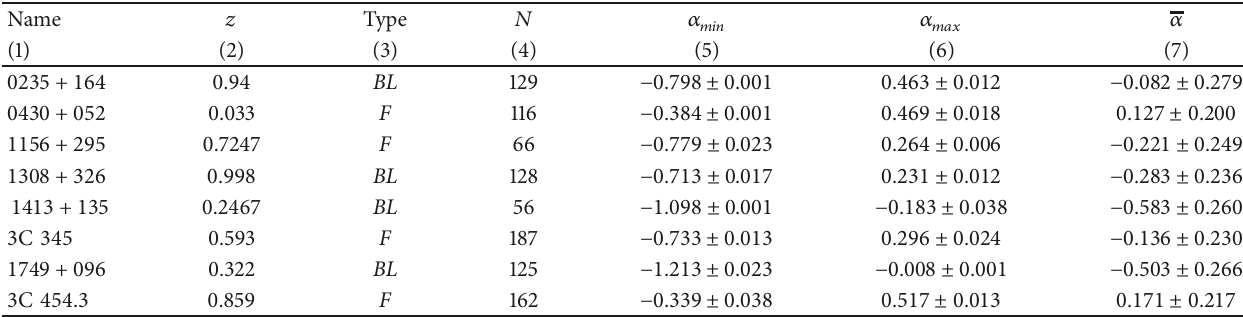
Table 1: The spectral indices of 8